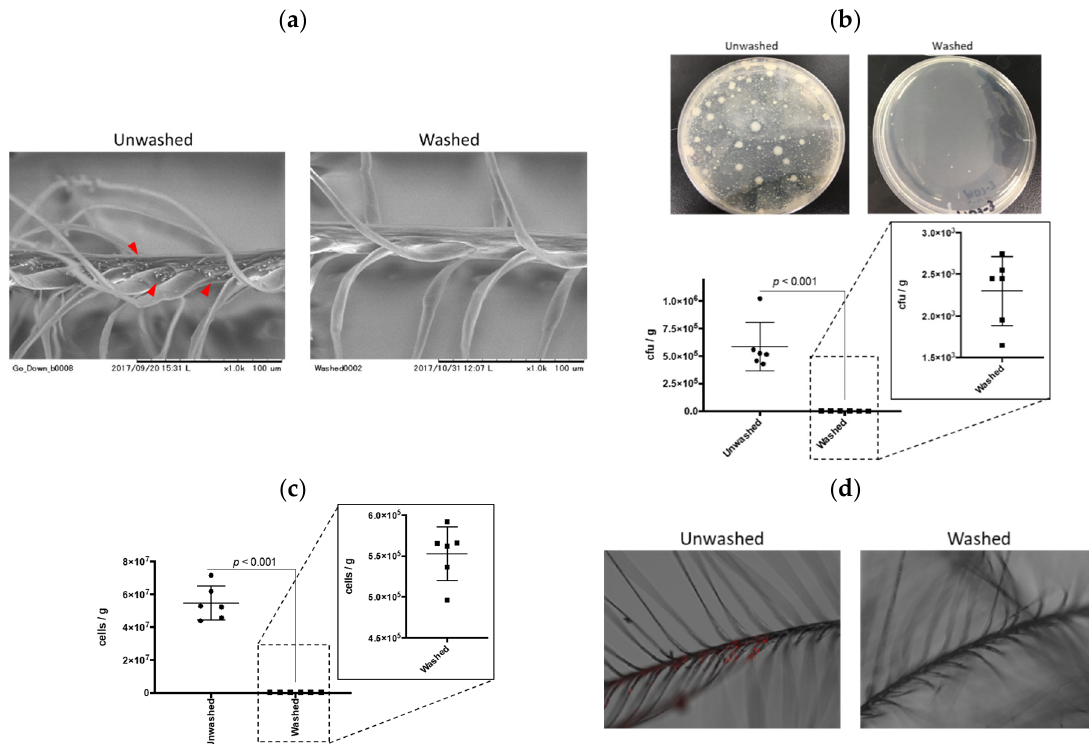
Figure 1. qPCR quantification of contaminated bacteria in down and feather samples. ( a ) Scanning electron microscopic images of unwashed and washed down and feather. Red arrowheads indicate debris. ( b ) Colony-forming unit (CFU) of down and feather samples. CFU was calculated using standard agar plate protocol. n = 6, error bars indicate SD. ( c ) qPCR analysis of bacterial numbers in down and feather samples. n = 6, error bars indicate SD. ( d ) Bacterial proliferation in the down and feather samples. Red signal indicates mCherry-expressing E. coli .